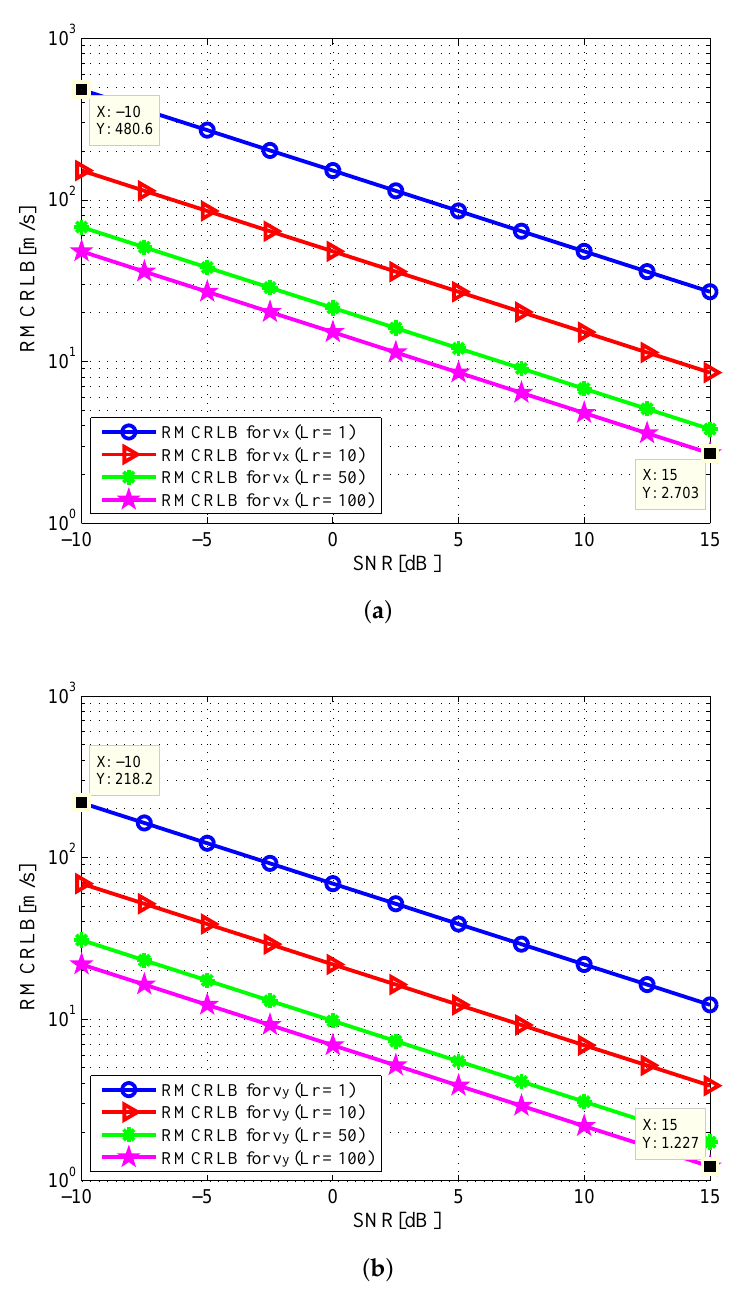
Figure 3. RMCRLB versus SNR in target velocity dimensions with different L r : ( a ) x-velocity; ( b )